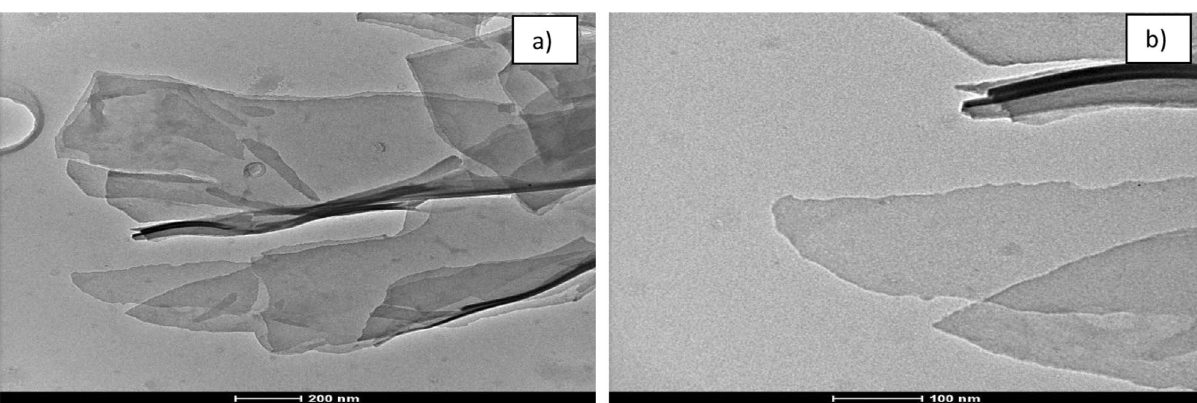
Figure 2. TEM images of TPEG. The different scales of the images are reported to evidence the different